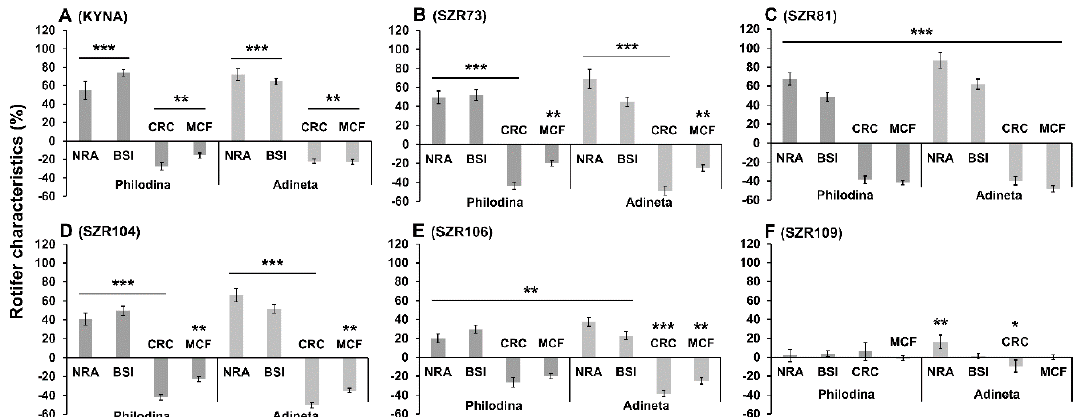
Figure 3. Biological characteristics of rotifers under treatment (100 µM) with KYNA or its analogs showing contradictory profiles. On day six, three experimental- (number of rotifers alive (NRA), body size index (BSI), mastax contraction frequency (MCF)) and one chemical cellular reduction capacity (CRC) parameter of individual rotifers and the populations were monitored. KYNA ( A ) and its SZR analogs ( B – E ) had antagonistic profiles for the following characteristics: NRA-BSI compared to CRC-MCF pairs, with the exception of SZR109 ( F ). Both Philodina and Adineta species show significant differences from their untreated controls (showing as 0 value on the x axis in graphs). The error bars represent SEM. One-way ANOVA with Bonferroni post hoc test was used for statistical analysis, the levels of significance are * p ≤ 0.05, ** p ≤ 0.01 and *** p ≤ 0.001. (*, significant difference from untreated controls, where the corresponding data of 100% is the 0 value on the x axis); NRA, n = 24 wells; BSI, n = 50 randomly selected individuals from 24 wells; CRC, n = 24 wells; MCF, n = 50 randomly selected individuals from 24 wells).